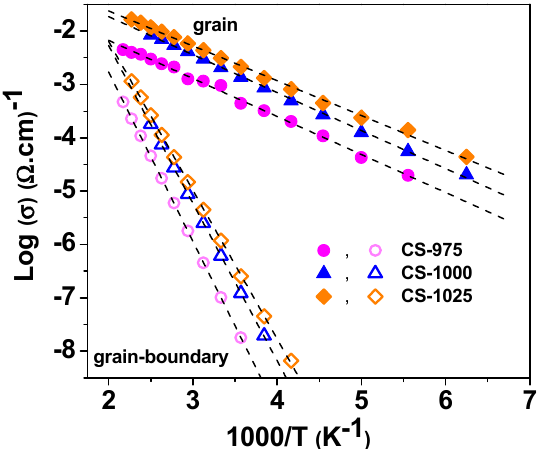
Figure 6. The temperature dependence of the grains and grain-boundary conductivity of LCTO ceramics.